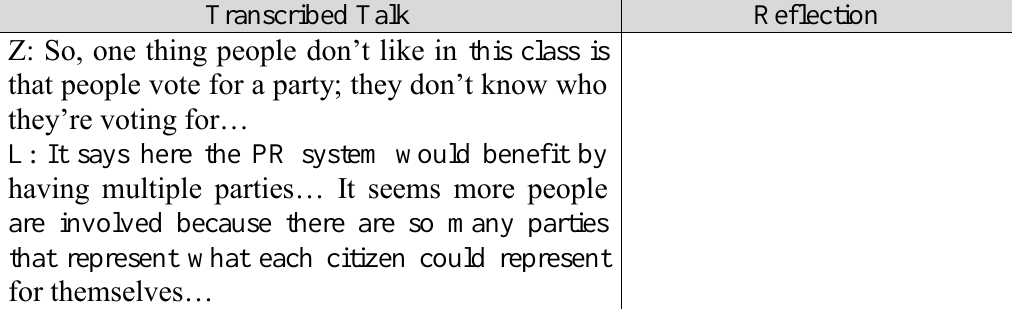
Table 2. Turn-Taking, Extending, Yes,